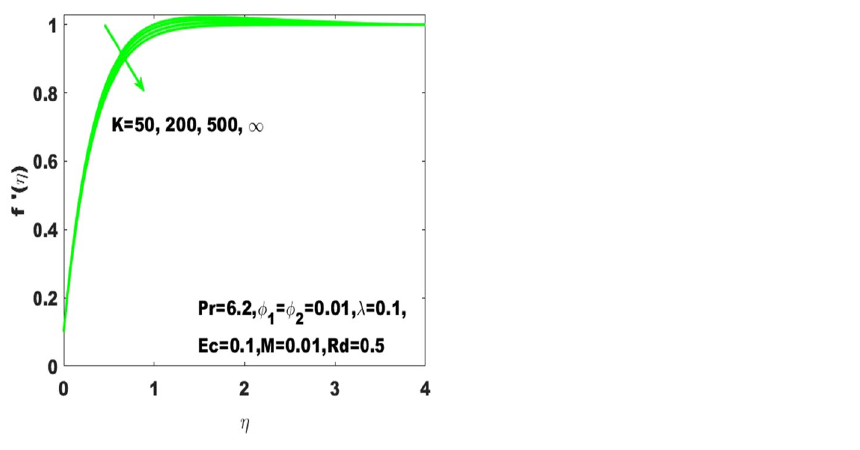
′ ( η ) Figure 14. f for the diverse values of K .